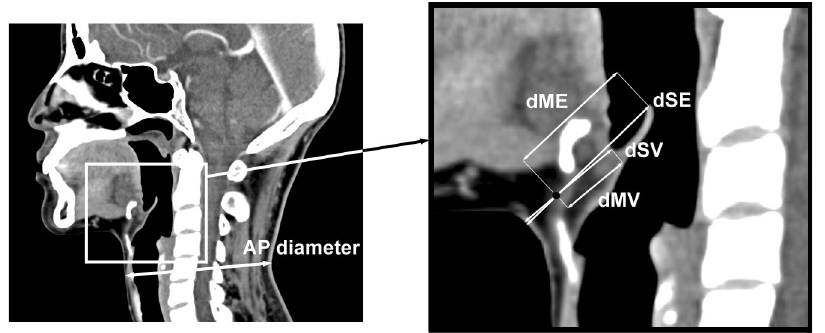
Figure 1. Anterior neck measurements. The picture on the right is an enlarged image of the white box on the picture on the left. The neck anterior–posterior (AP) diameter is the shortest AP distance that passes the centre of the cricoid cartilage on the lowest axial section of the cricoid. The membrane-to-vallecula distance (dMV) is the distance from the midpoint of the thyrohyoid membrane between the hyoid bone and laryngeal prominence to the closest concave point of the vallecula. The membrane-to-epiglottis distance (dME) is the distance from the midpoint of the thyrohyoid membrane between the hyoid bone and laryngeal prominence to the furthermost tip of the epiglottis. The skin-to-vallecula distance (dSV) is the extended distance straight to the skin anterior from the dMV. The skin-to-epiglottis distance (dSE) is the extended distance straight to the skin anterior from the